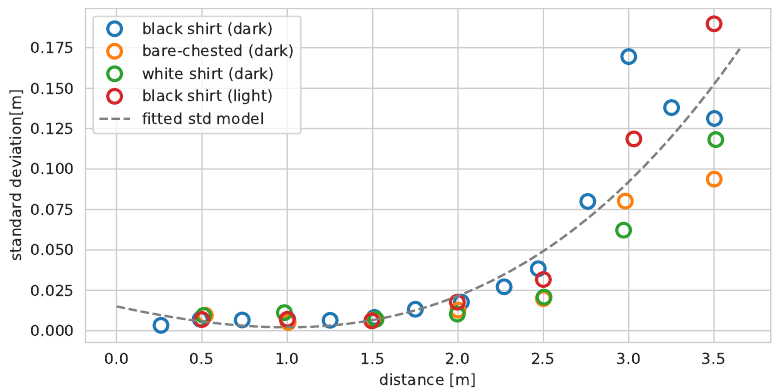
Figure 8. Ranging standard deviation for reflections from a person clad in different clothes. The coefficients of the fitted model are stored in Table 2.